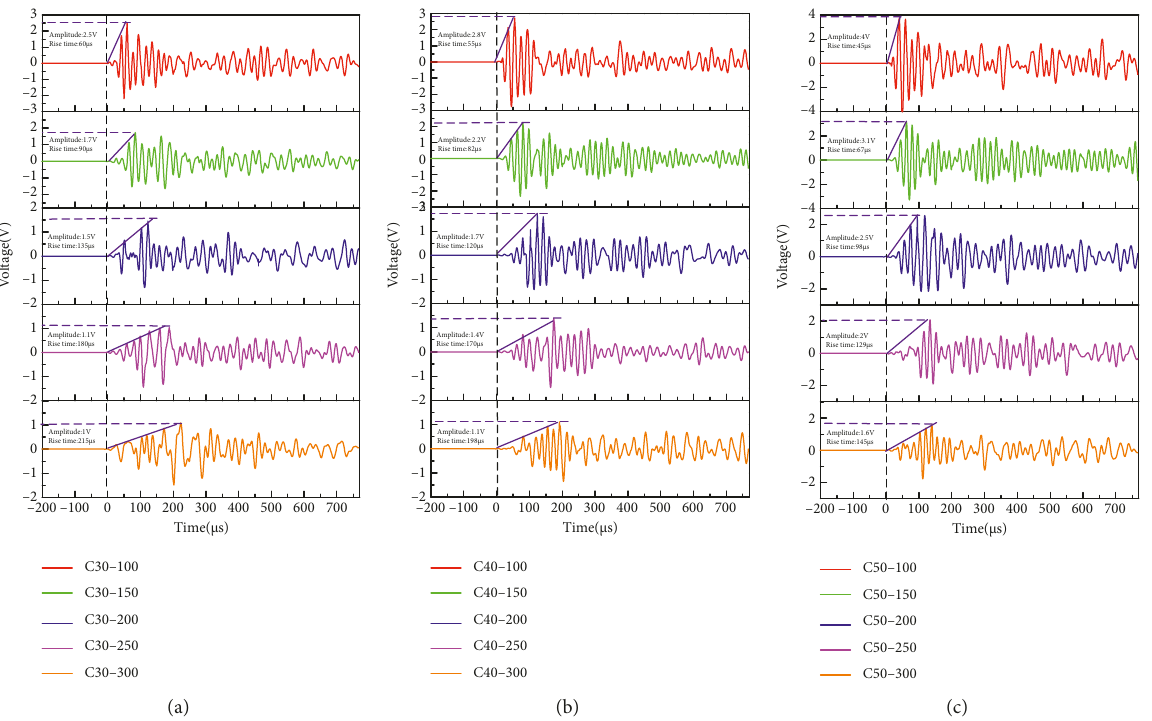
Figure 14: Time-domain spectra of acoustic emission signals in concrete with strength grade. (a) C30, (b) C40, and (c)